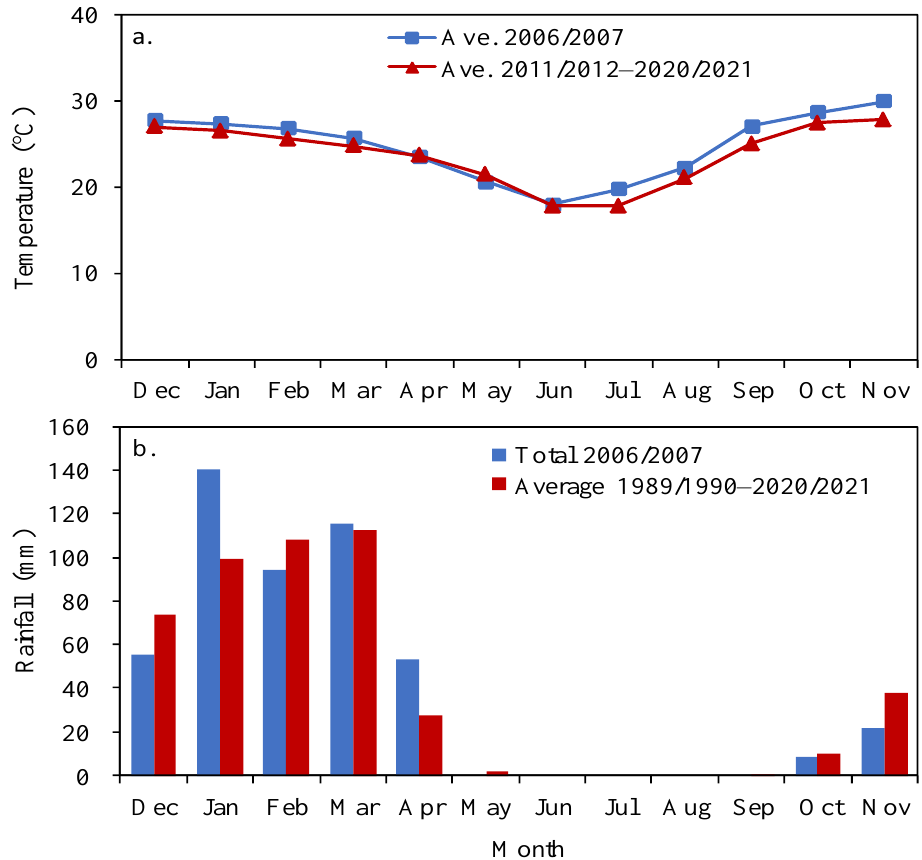
Figure 2. Patterns of monthly average temperatures for 2006/2007 and 2011/2012 – 2020/2021 period ( a ) monthly total rainfall for 2006/2007 and monthly average rainfall for the 1989/1990 – 2020/2021 period; ( b ) in North-Central Namibia. Ave., average. Data source: Rainfall data, Omahenene Re- search Station; temperature data, Ondangwa Weather